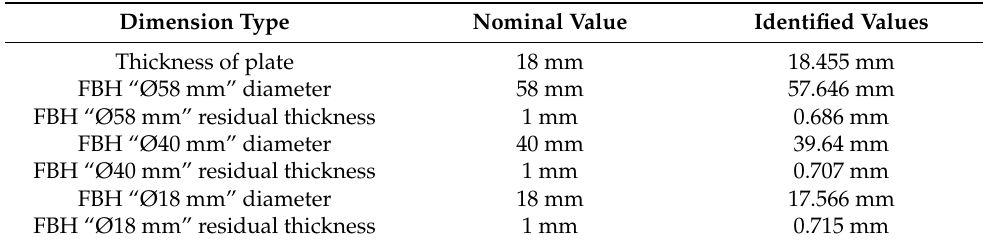
Table 1. Design and measured dimensions of the test sample.